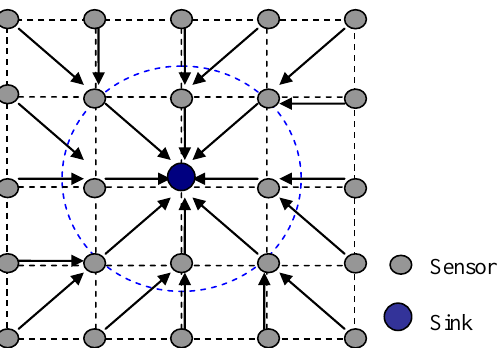
Figure 9. Network topology in